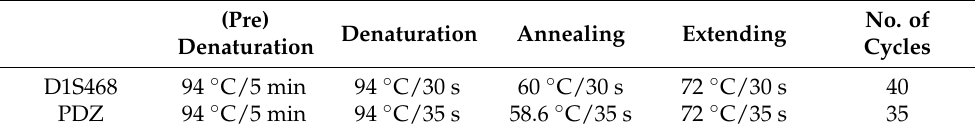
Table 2. PCR conditions for the DVL1 microsatellite marker D1S468 and the PDZ genetic regions.